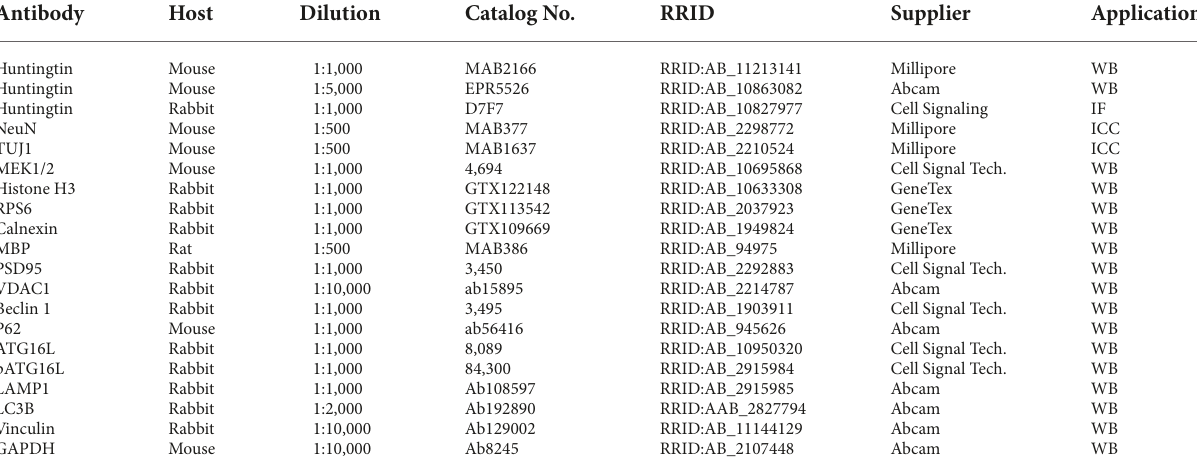
TABLE 1 Antibodies used in the study. Antibody Host Dilution Catalog No. RRID Supplier Application